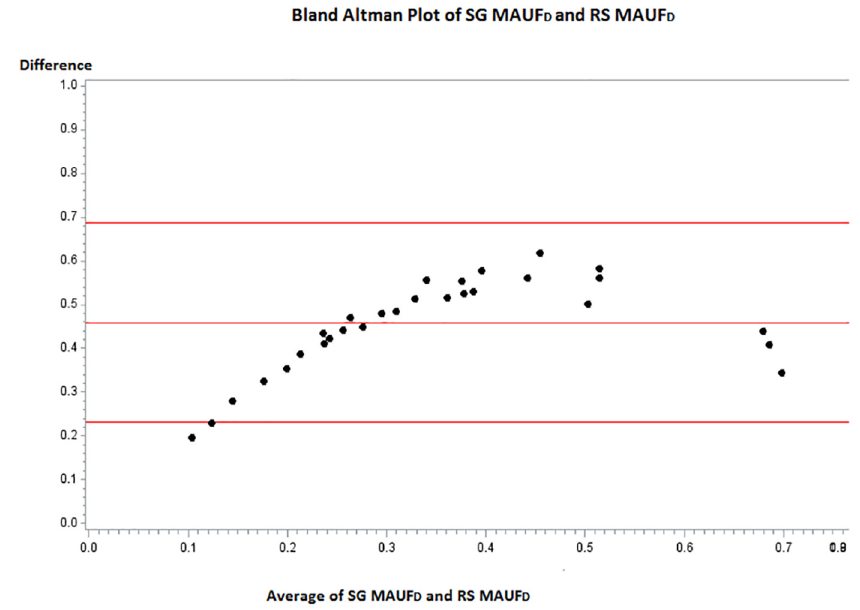
Fig 5. Bland-Altman plot to assess agreement between the SG MAUF D and the RS MAUF D in the development sample.